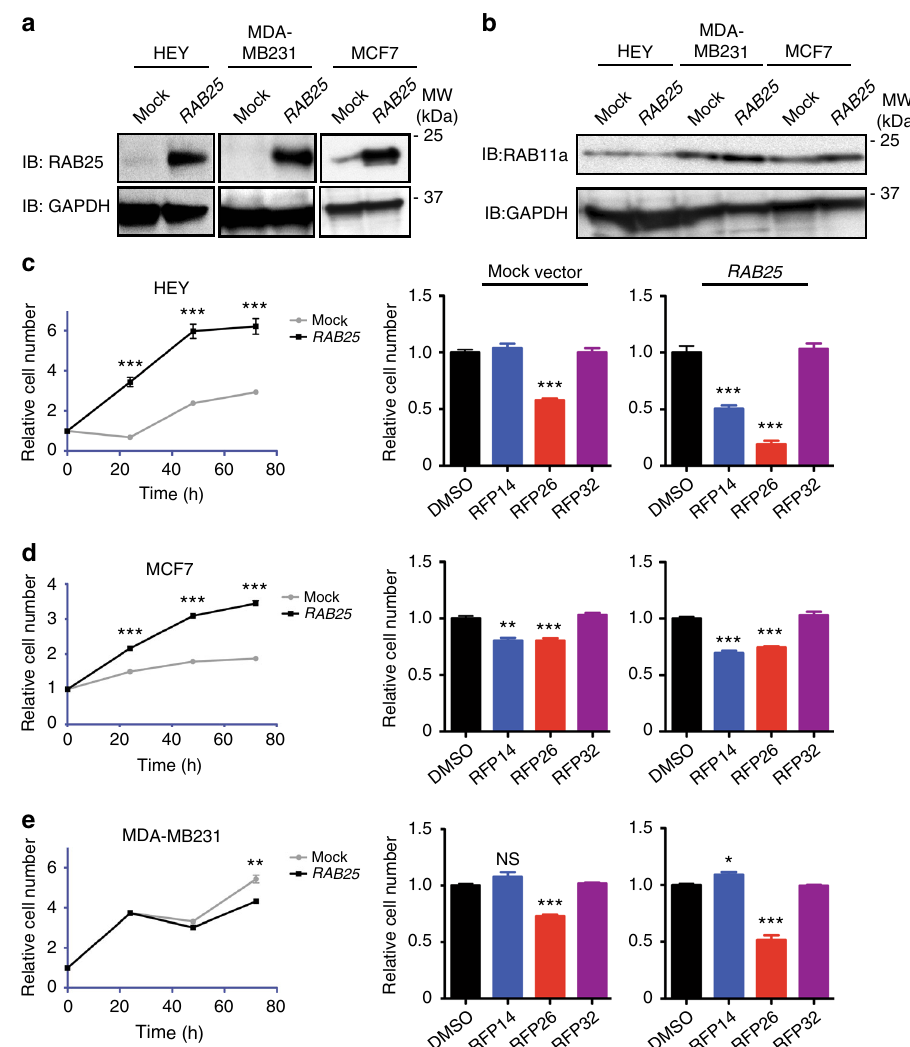
Fig. 4 RFP peptides alter RAB25-driven cell proliferation. a Western blot analysis of mock vector and RAB25 overexpressing HEY, MDA-MB231, and MCF7 cells. b Western blot analysis for endogenous RAB11a in HEY, MDA231 and MCF7 isogenic lines with or without RAB25 overexpression. c Left panel compares the viability of untreated HEY cells under low-serum condition in mock or RAB25 expressing lines while right panel shows the effects of treatment with DMSO or RFP14, 26, and 32 (15 μ M) on the viability of HEY mock or RAB25 expressing cell lines at 48 h post-treatment. d , e shows corresponding results from MCF7 isogenics and MDA-MB231 isogenics, respectively. RAB25 expression results in enhancement (HEY, MCF7) or inhibition (MDA-MB231) of cell proliferation, which is reversed by RFP14, but not RFP32. Images and data shown represent mean ± s.e.m. of triplicate biological replicates. * P < 0.05; ** P < 0.01; *** P < 0.001, Student ’ s t -test. NS, not signi fi